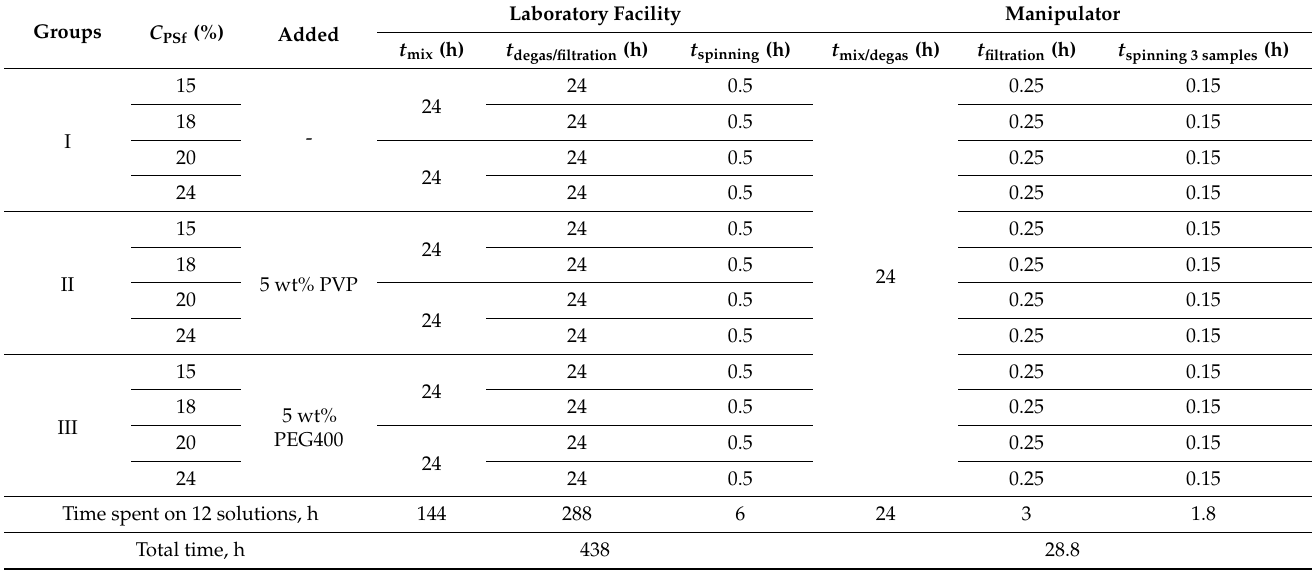
Table 8. Calculation of the sample preparation time at the laboratory facility and at the manipulator for 12 solutions.